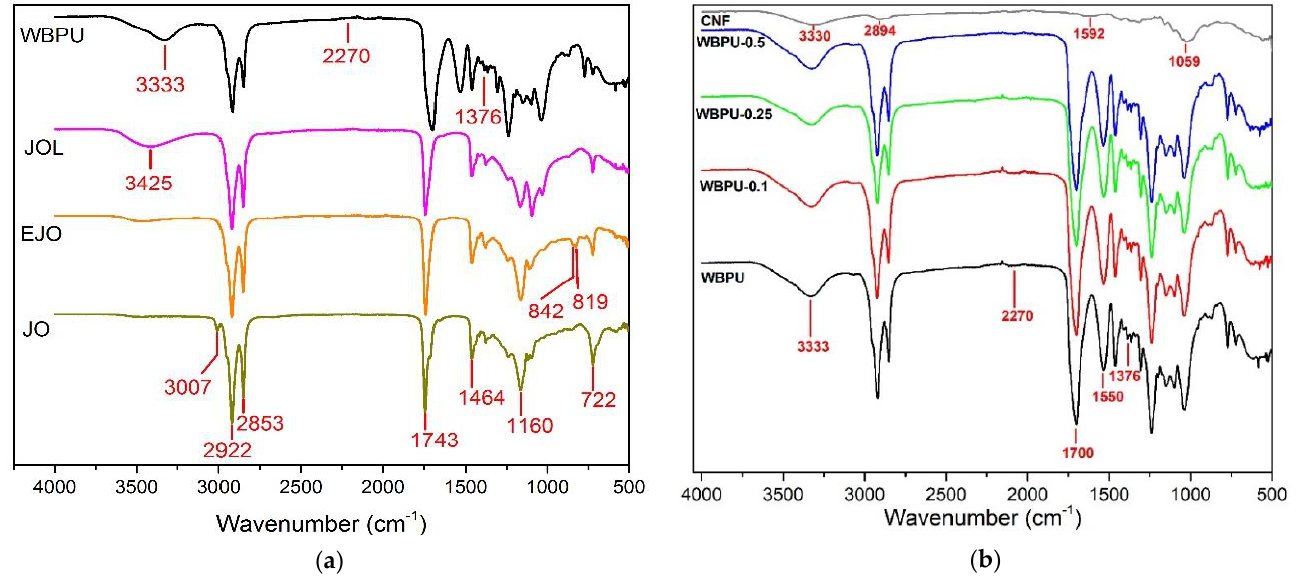
Figure 2. FTIR Spectra of: ( a ) JO, EJO, JOL, WBPU; ( b ) WBPU-CNF and CNF nanocomposite films. Table 2. Characterization of vibrational bands of